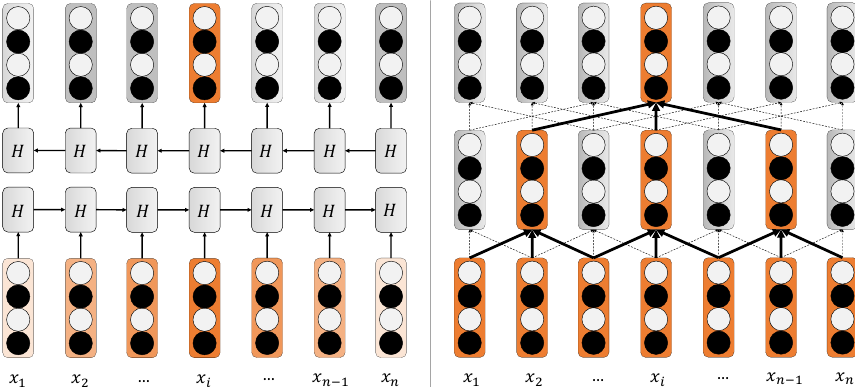
Figure 1. The left figure shows the traditional Bi-LSTM model. The input of the current moment of the Bi-LSTM model depends on the output of the previous moment, so at time i , the calculation must be iterative from left to right and iteratively calculated from right to left. The figure on the right is the Iterated Dilated (ID)-CNNs model. It is similar to the CNN structure and can be calculated in parallel. In addition, the receptive field is expanded between layers, so that global semantic information can be